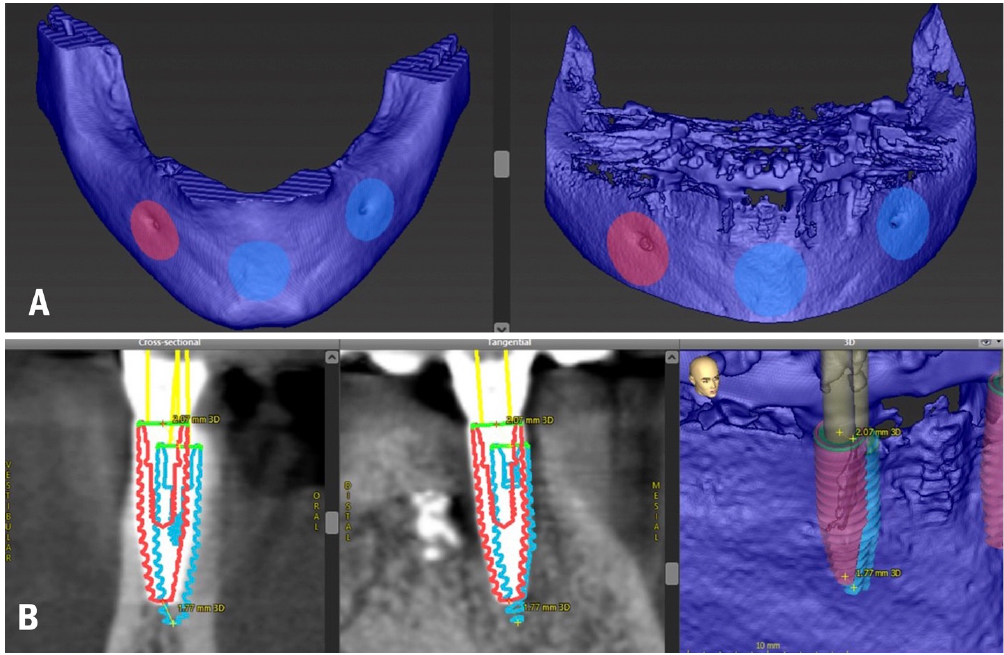
Figure 2. ( A ) Planning and postoperative CBCT matching; ( B ) Accuracy analysis with postoperative CBCT (blue colour—planned implant position, red colour—actual implant position).